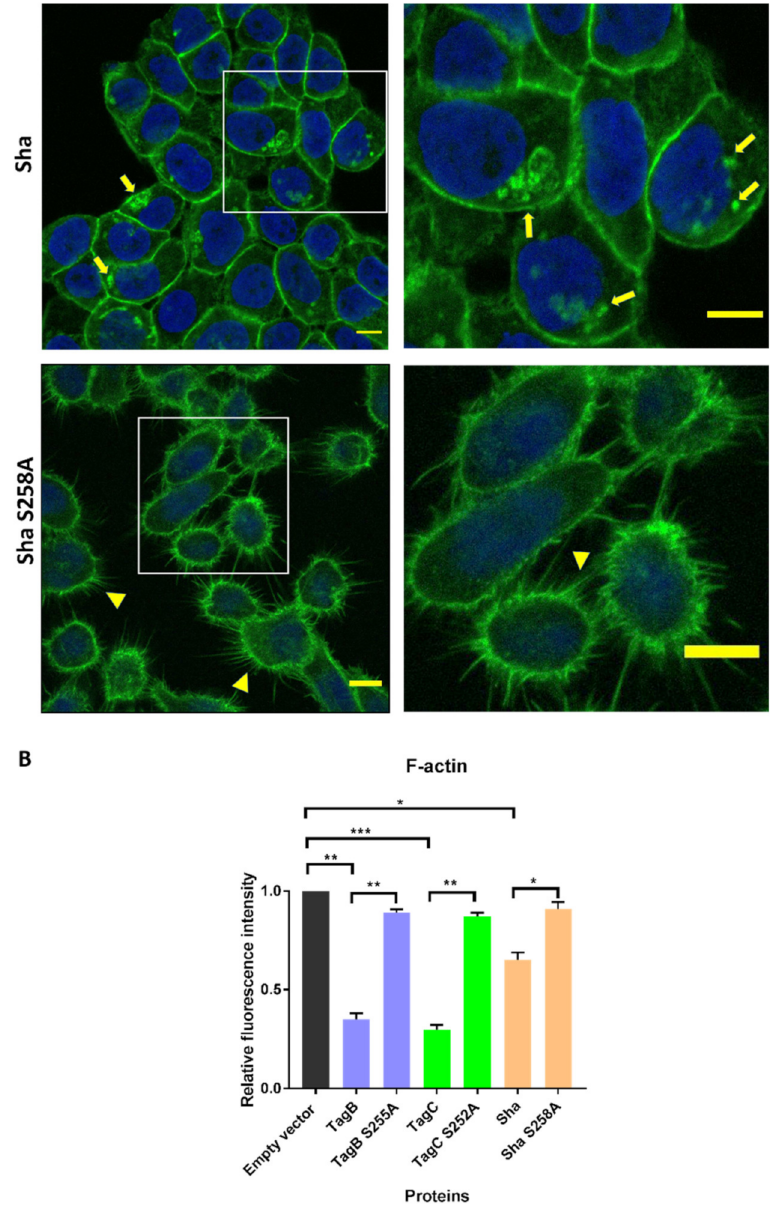
Figure 4. E ff ects of TagB, TagC, and Sha on the actin cytoskeleton of bladder epithelial cells is serine-protease-motif dependent. ( A ) Concentrated supernatant extracts (30 µ g of protein per well) from E. coli BL21 clones expressing TagB, TagC, or Sha and their respective serine catalytic site mutants wereincubatedwithmonolayersofhumanbladder(5637)epithelialcellsfor5hat37 ◦ C.Afterincubation, cells were fixed and permeabilized. Actin was stained with fluorescently labeled phalloidin (green) and the nucleus was stained by DAPI (blue). Cells treated with the filtered supernatant of E. coli BL21 pBCsk + without insert (empty vector) were used as a negative control. Slides were observed by confocal microscopy. Inset images from the left panels are magnified in the panels to the right. Bars represent 10 µ m. ( B ) Quantitative analysis of fluorescence intensity of F-actin. Analysis of fluorescent intensity was done at the original magnification by measuring the mean gray value with ImageJ software [22] with an n value of at least 10 cells. Data values represent the mean ± SEM of at least three independent experiments. (* p < 0.05, ** p < 0.01, *** p < 0.001 one-way ANOVA with multiple